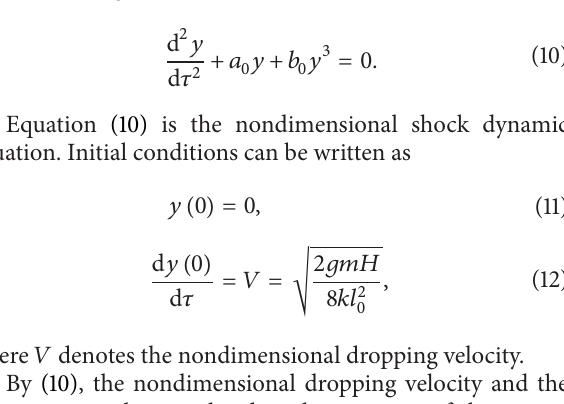
middle of the container by 8 springs (four springs are on the upside, and the other four are on the